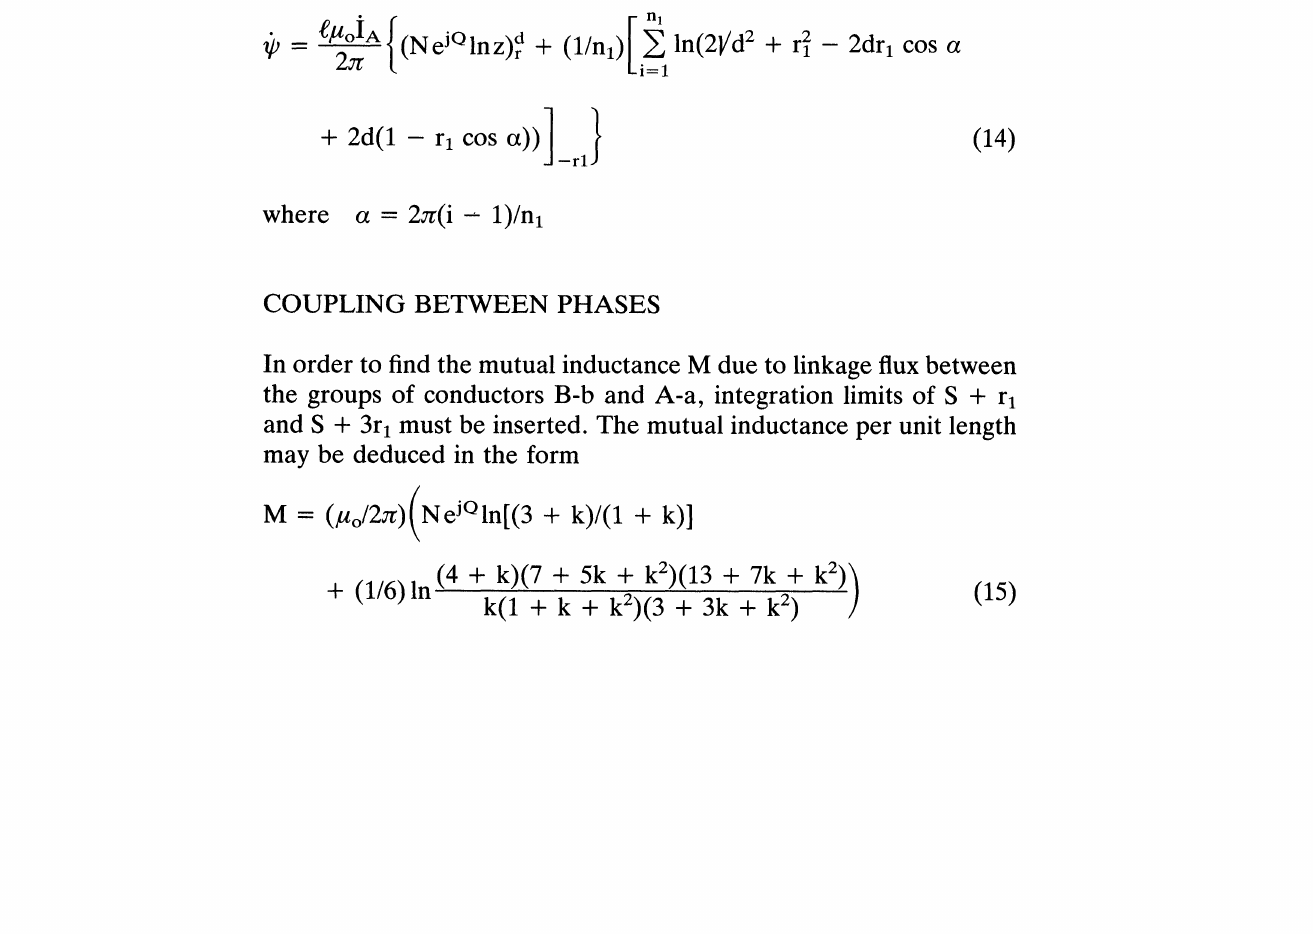
FIGURE 6 The transposition diagram for the conductors of phases of the coaxial type transmission